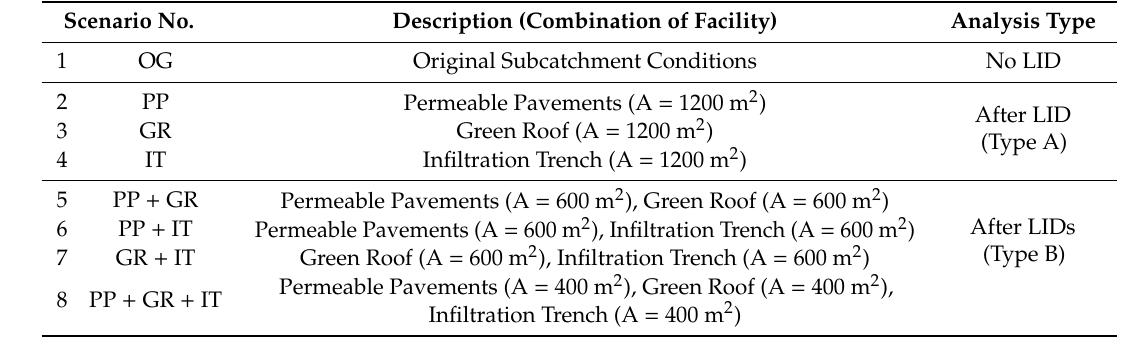
Table 5. Modeling approach and scenario